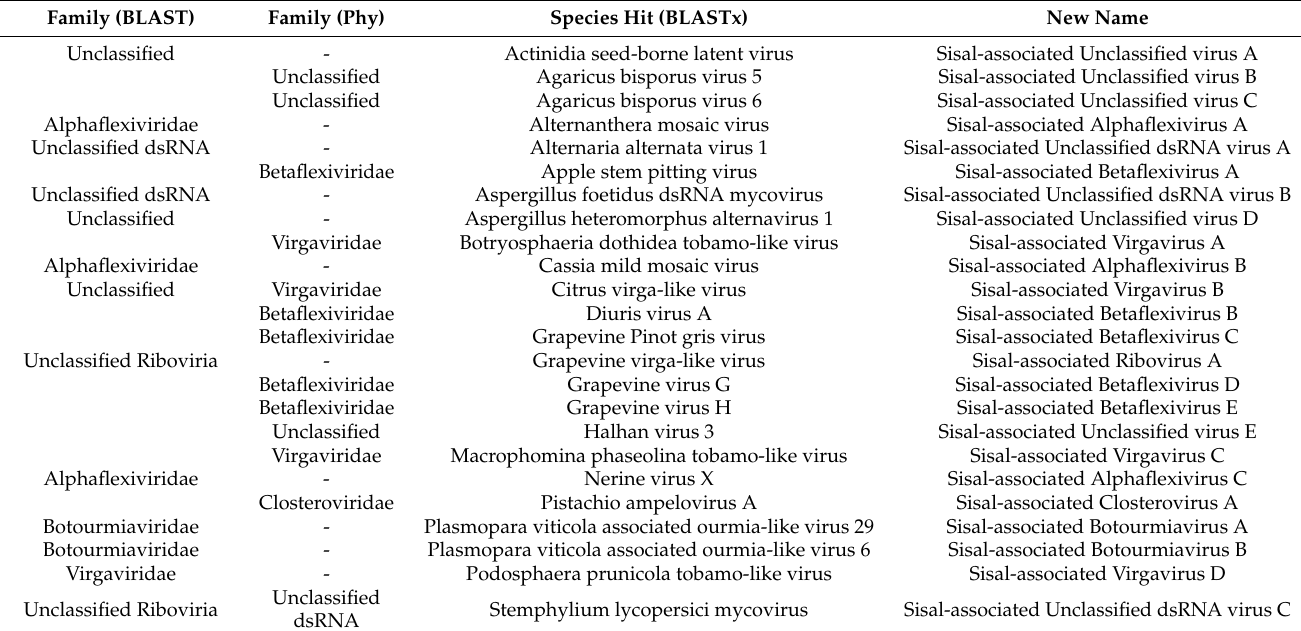
Table 1. Viral species assignments according to sequence similarity searches and phylogeny. Columns indicate (i) the family indicated by phylogeny, (ii) the family of the best BLASTx hit (columns merged when results are identical), (iii) the species of the best BLASTx hit, and (iv) the new species